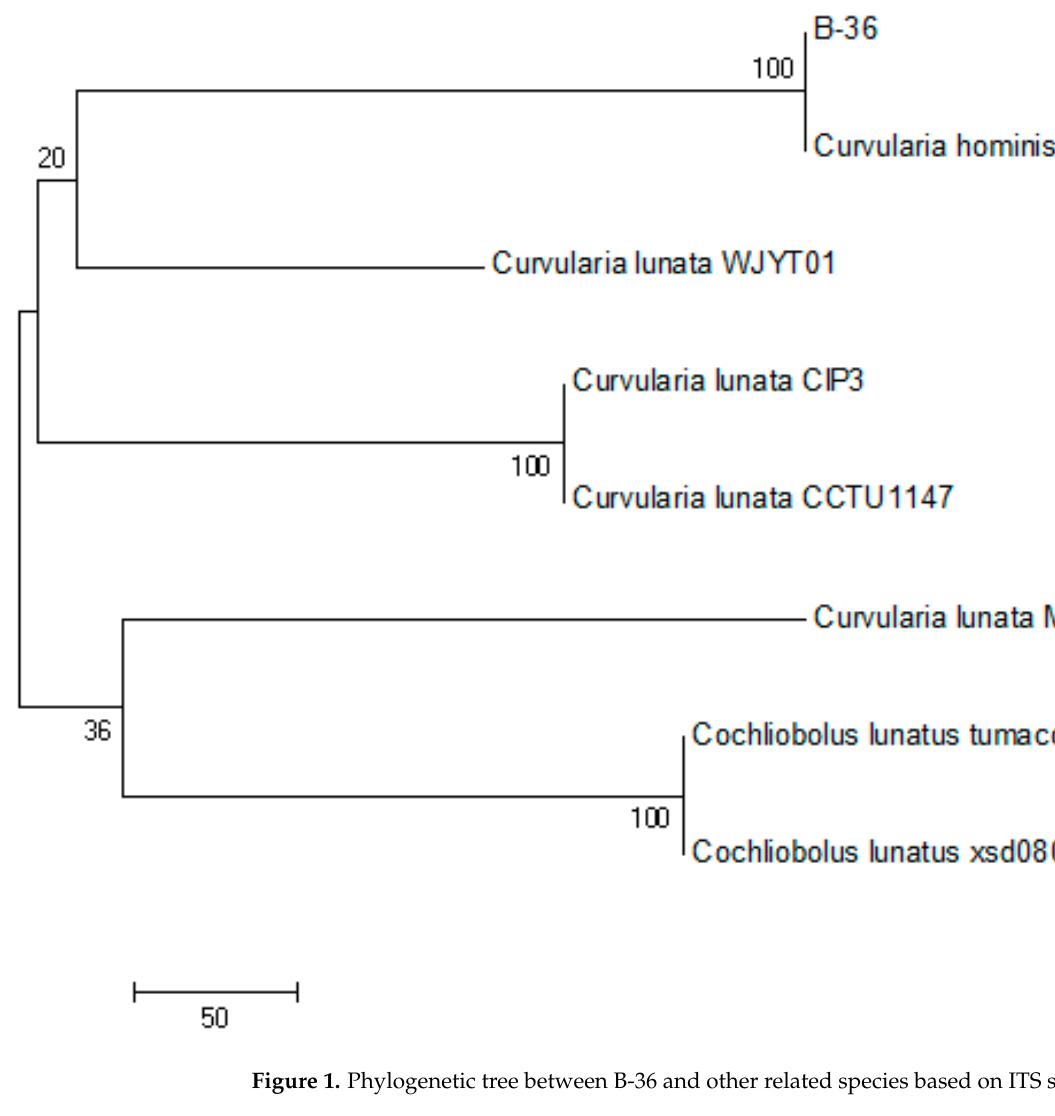
Figure 1. Phylogenetic tree between B-36 and other related species based on ITS sequences.